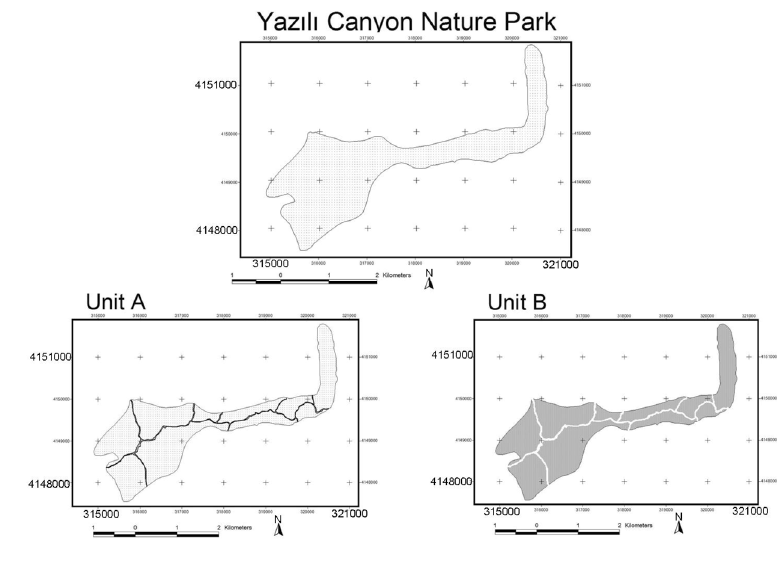
Fig. 4. Division of Site unit A and Site unit B